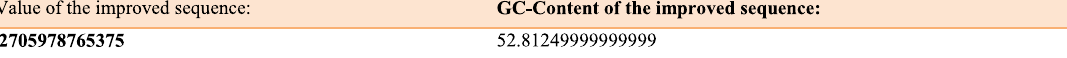
Fig. 6 Codon adaptation index for the gene of a finalized full-fledged vaccine construct against canine